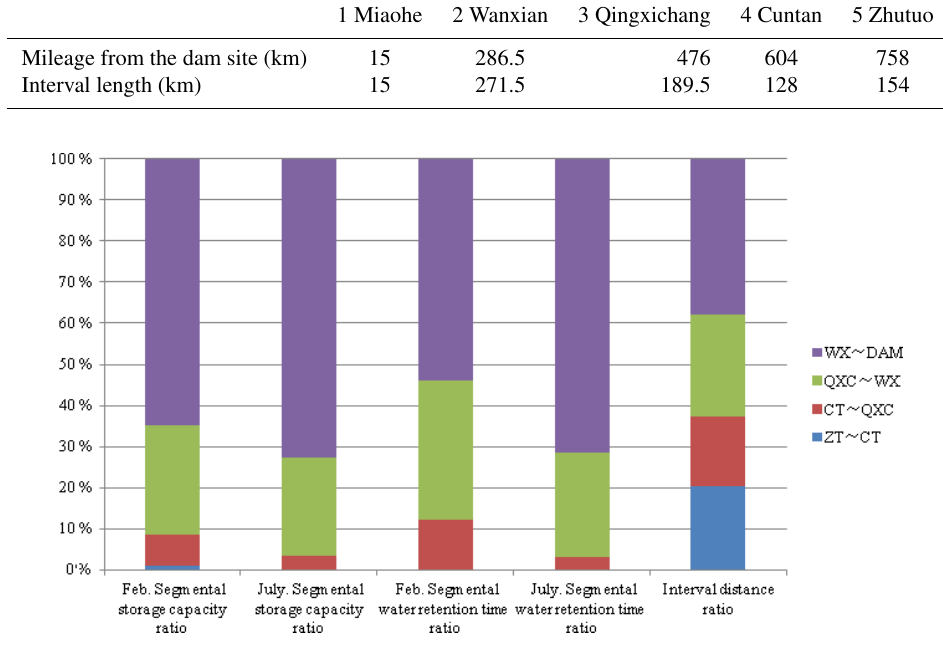
Figure 3. Statistics of the ratio of section storage capacity of the Three Gorges reservoir area from 2011 to